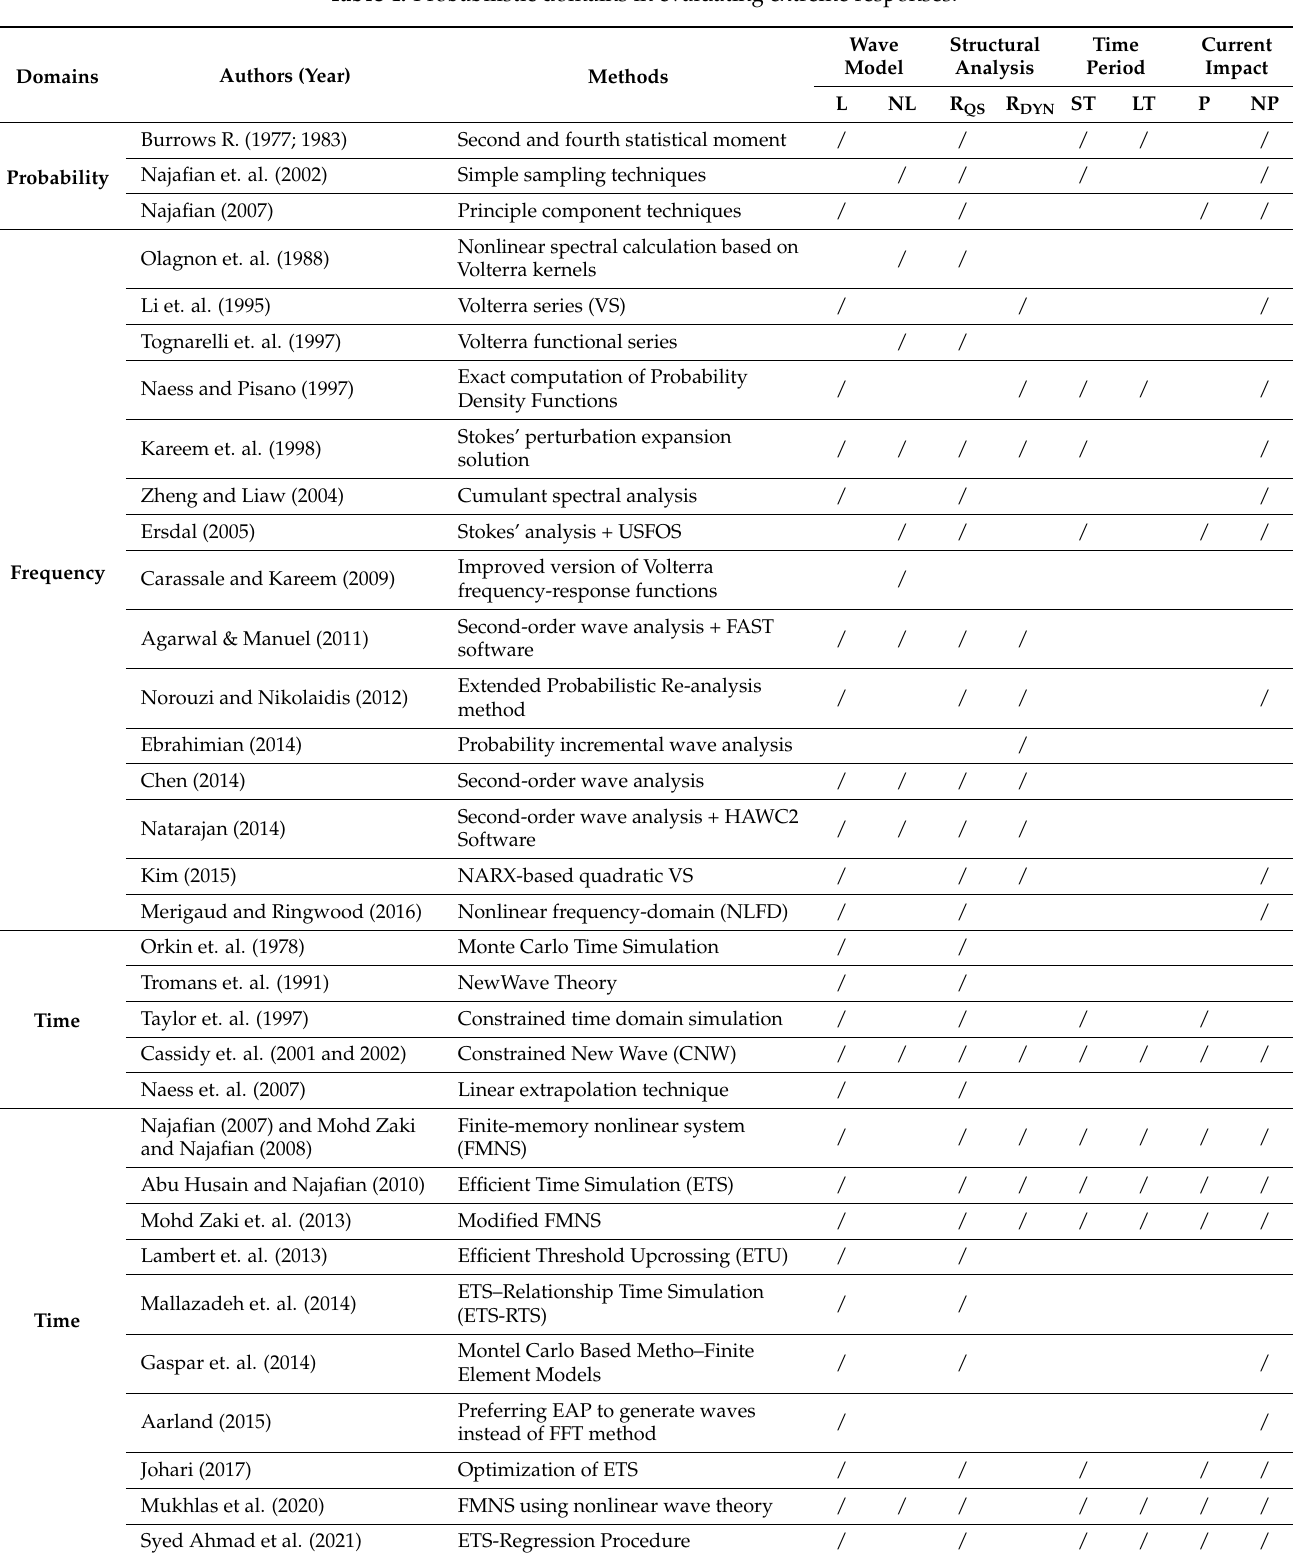
Table 4. Probabilistic domains in evaluating extreme